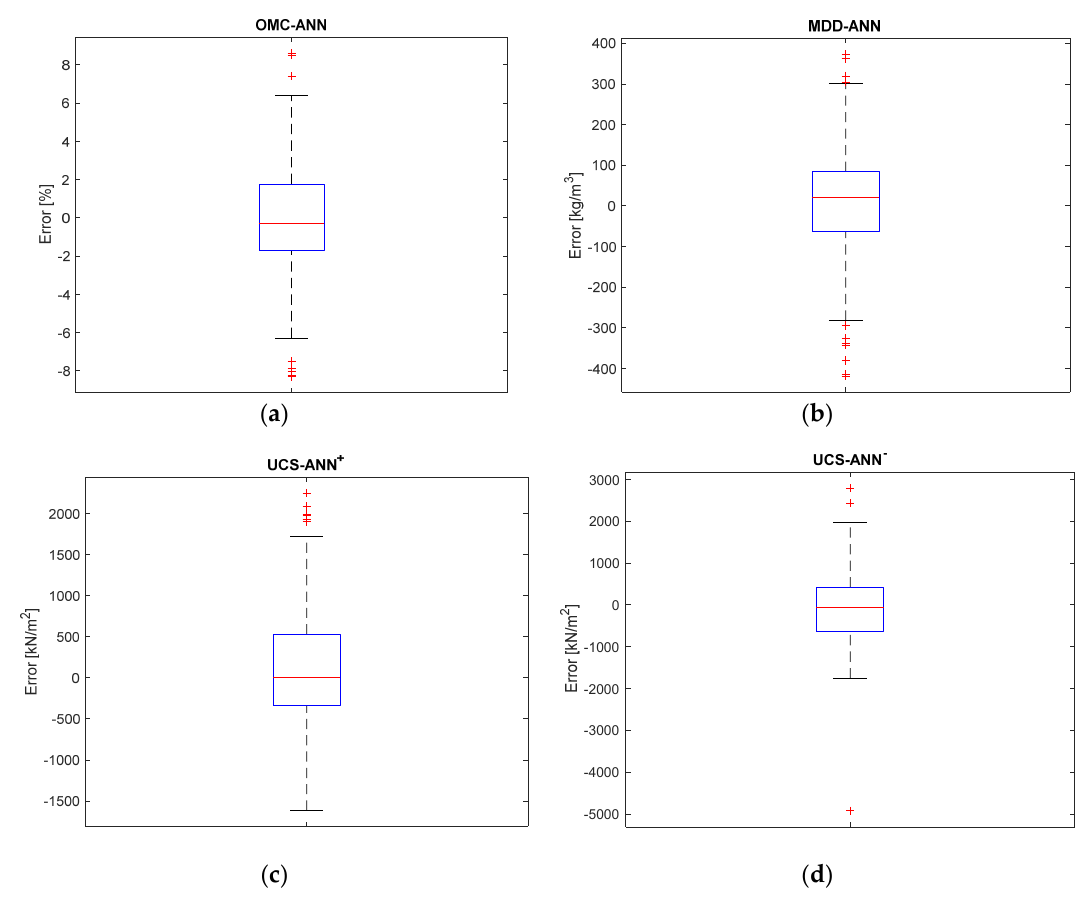
Figure 3. Distribution of errors in models of: ( a ) OMC-ANN, ( b ) MDD-ANN, ( c ) UCS-ANN + , and ( d ) UCS-ANN − . Table 5. Statistical performance measurements for models based on ensemble methods and ANN on unseen data.